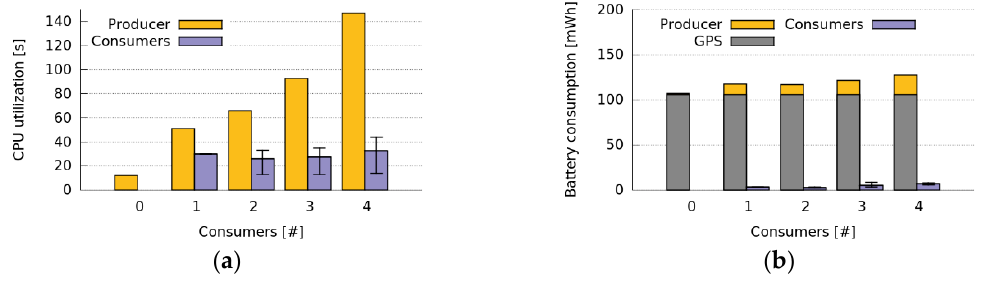
Figure 18. Producers and Consumers resource utilization when sharing GPS data continuously. ( a ) CPU utilization; ( b ) Battery Consumption.